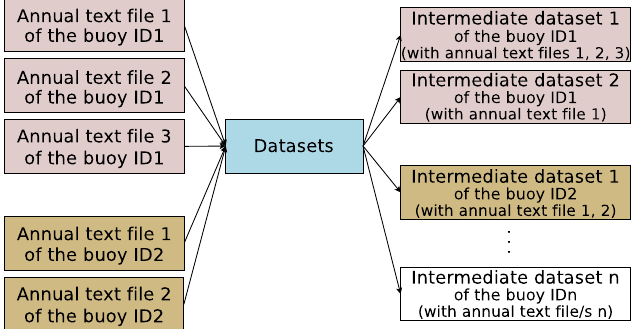
Figure 5. Example of the creation of the intermediate